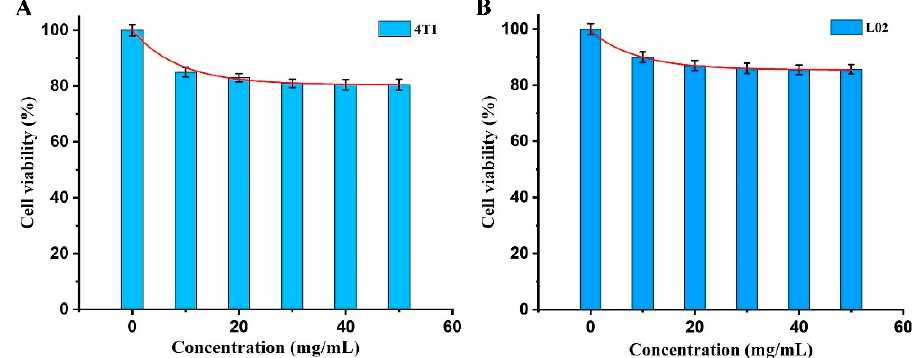
Figure 3. The cell viability of 4T1 cells ( A ) and L02 cells ( B ) was incubated with Au/Gd@FA NCs for 24 h. Error bars indicate the standard variance of three independent experiments. Data represent the means ± SD ( n = 3).